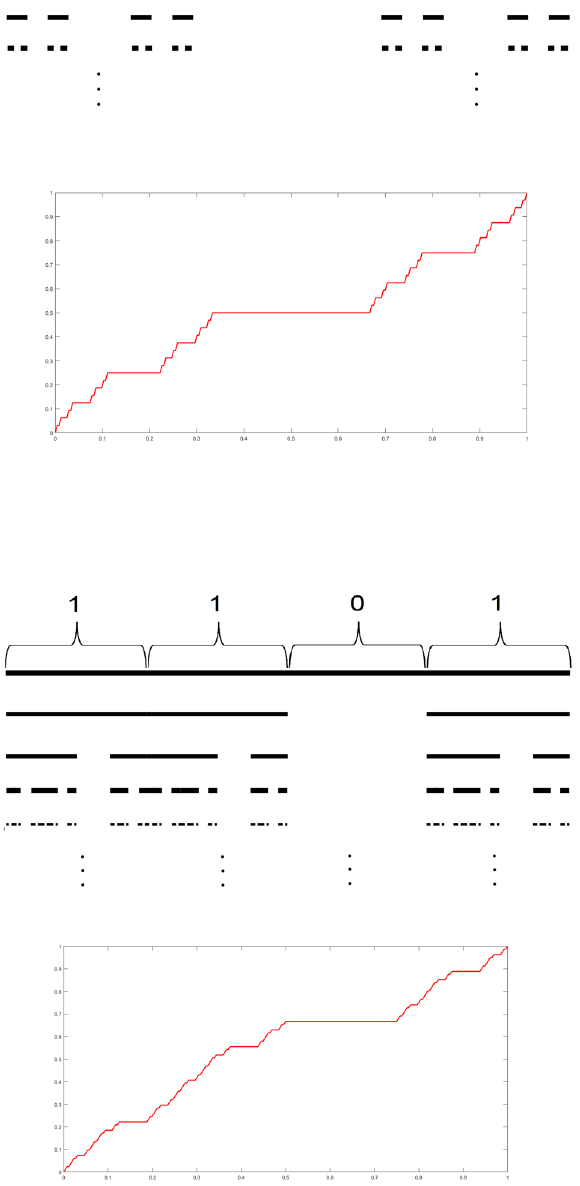
Figure 2: C 1,1,0,1 ( ) and F 1,1,0,1 ( ) .